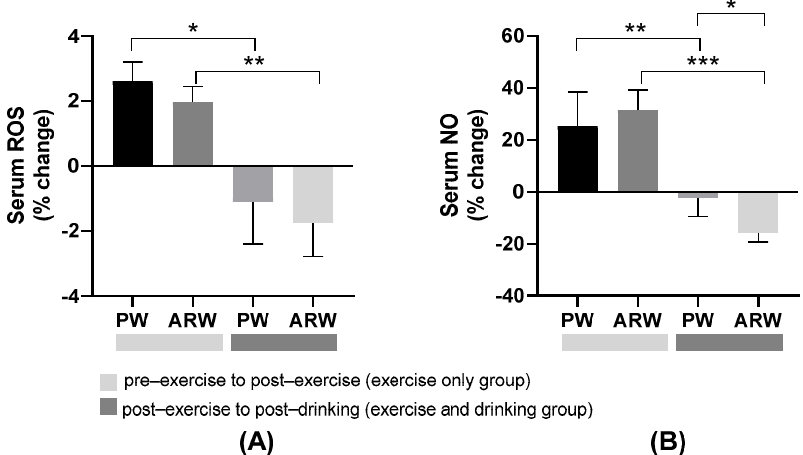
Figure 2. Effects of ARW consumption on ROS and NO levels of healthy individuals after intense exercise. Blood was collected from the participants pre- and post-exercise. Participants consumed PW or ARW after exercise and blood was collected. Fold changes in the serum levels of ROS ( A ) and NO ( B ) were calculated pre- to post-exercise and post-exercise to post-drinking. The statistical significance was analyzed via a one-way ANOVA (Mann–Whitney U test). * p < 0.05, ** p < 0.01, *** p < 0.001. Abbreviations: ROS, reactive oxygen species; NO, nitric oxide; PW, purified water-drinking group; ARW, alkaline reduced water-drinking group.